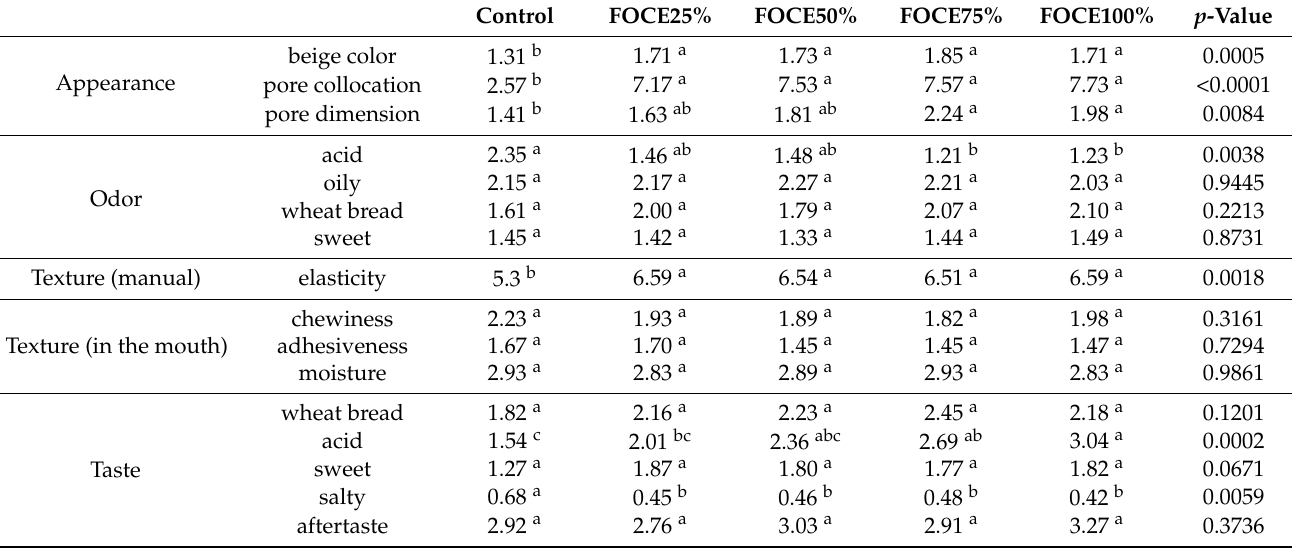
Table 4. The sensory characteristics of gluten-free breads with FOCE.